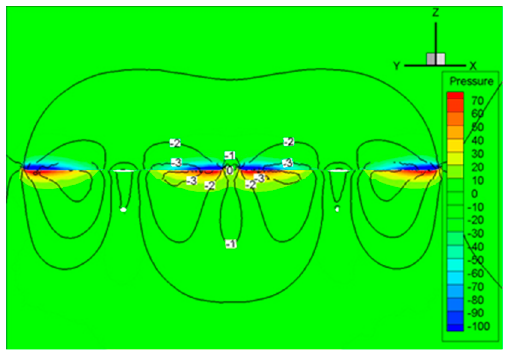
Figure 8. The pressure and velocity contours of the planar quadrotor with rotor spacing of 1.05 d